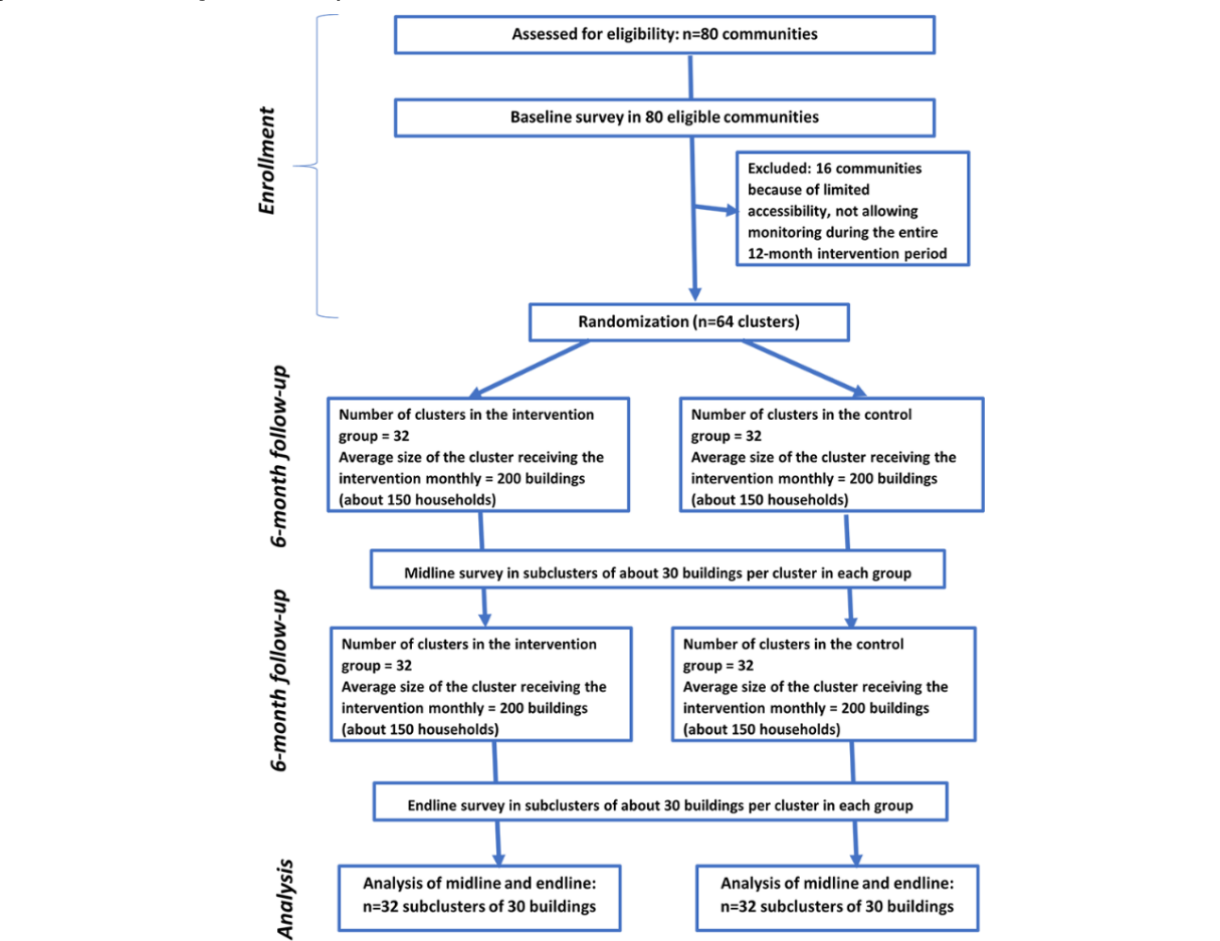
Figure 1. CONSORT diagram of the